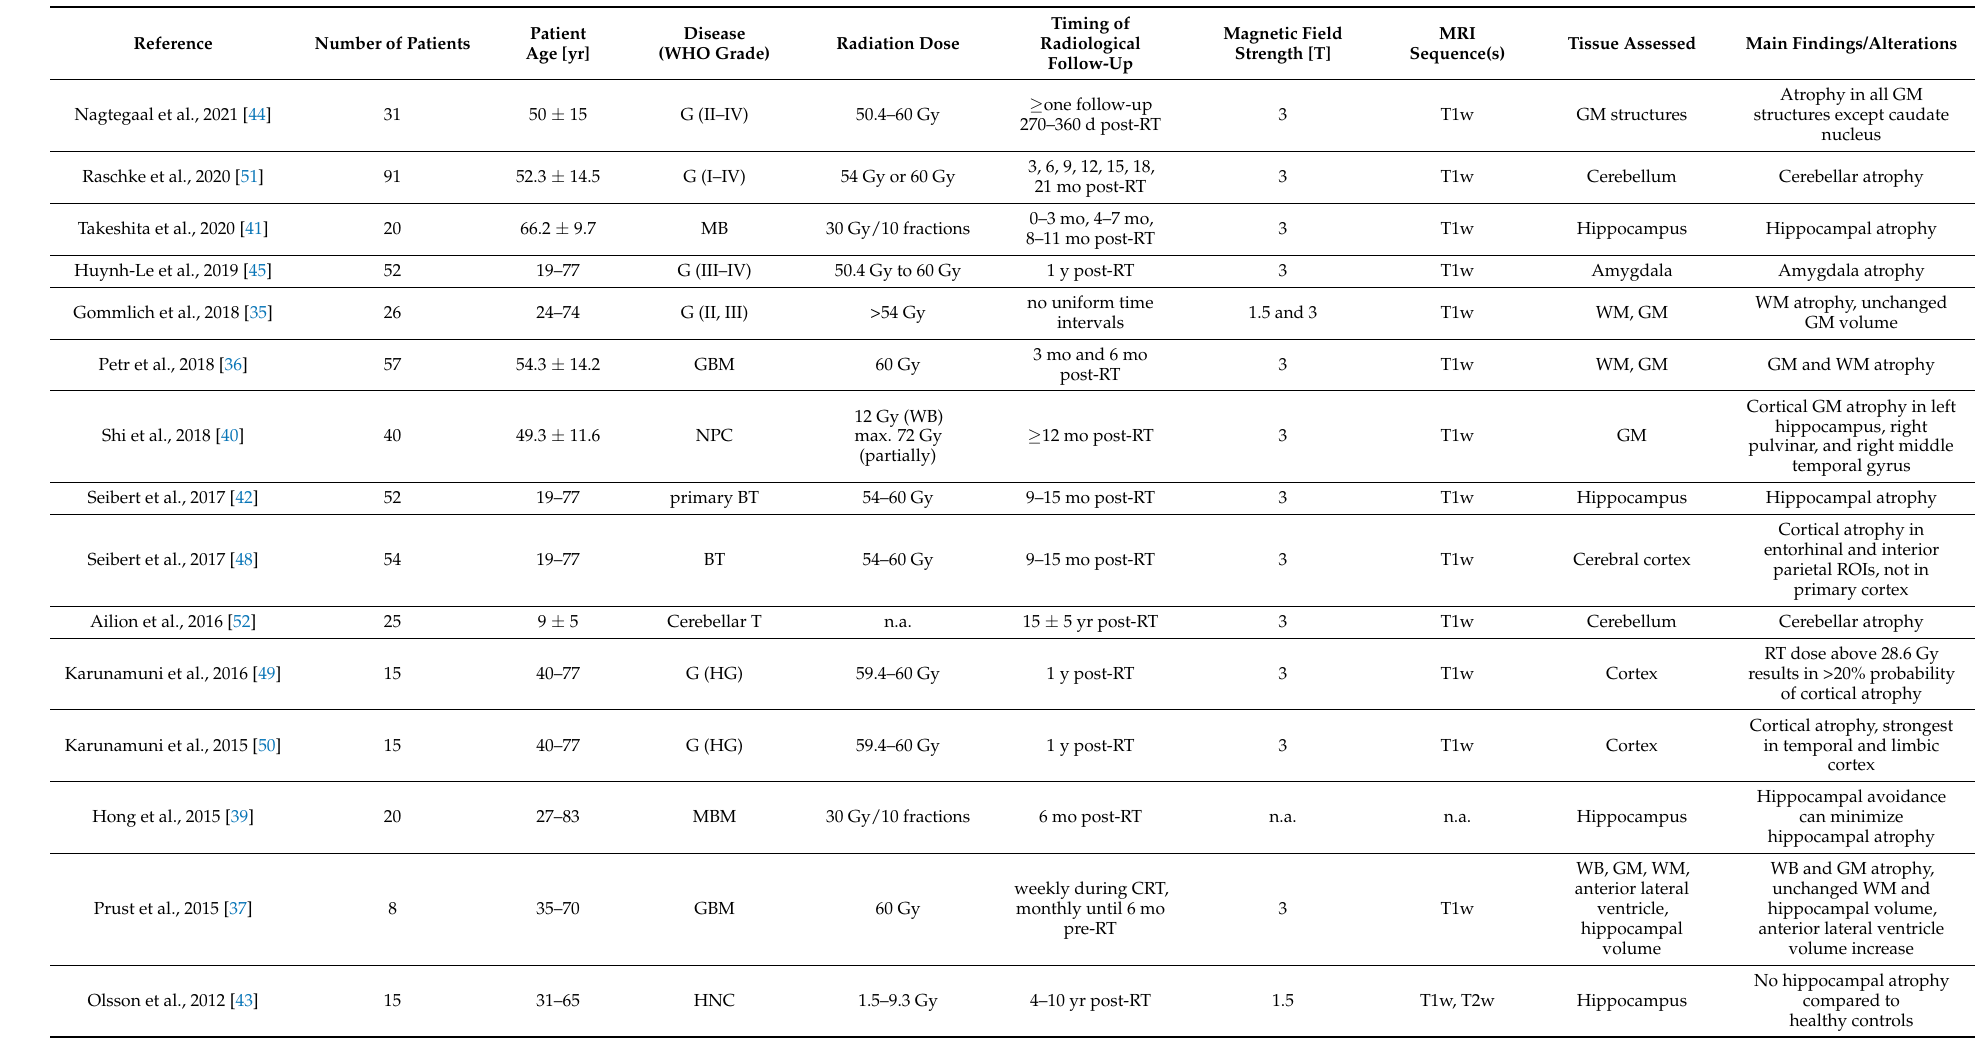
Table 1. Publications on anatomical/morphological changes in normal-appearing tissue after